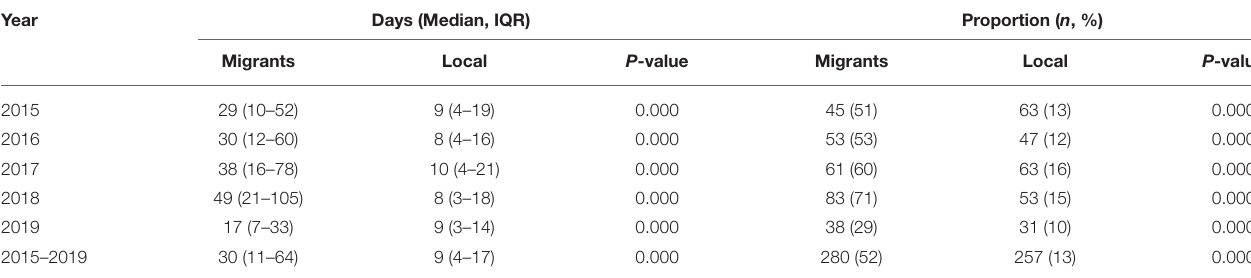
TABLE 2 | The total delay of migrant and local patients with TB from 2015 to